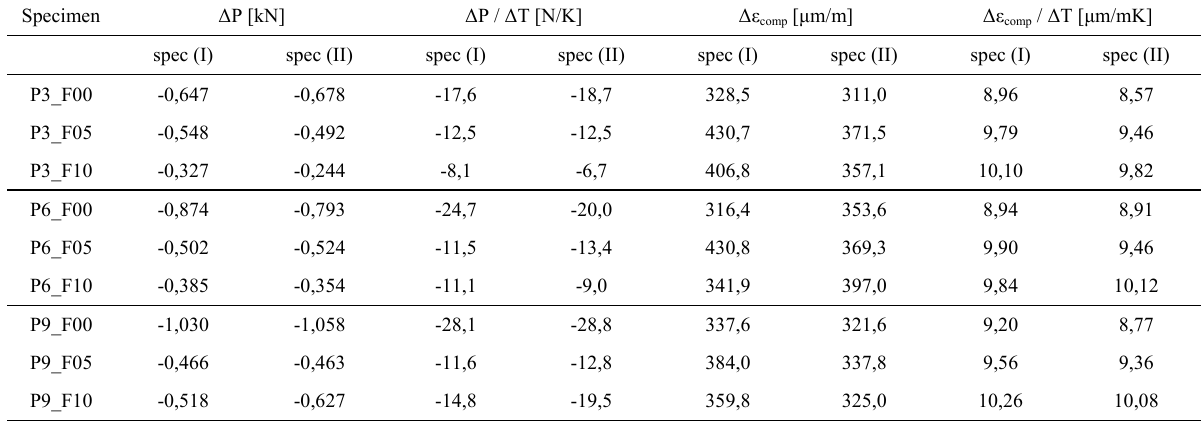
Table 4: Loss in cable load and change in strain versus change in ambient